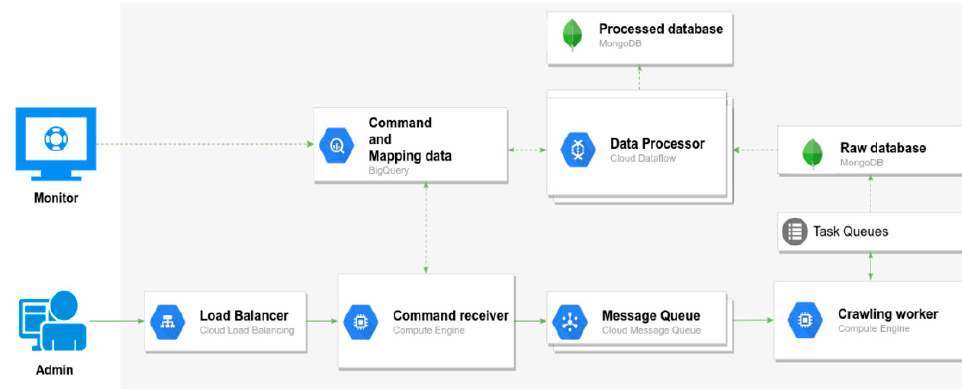
Figure 3. Data crawling